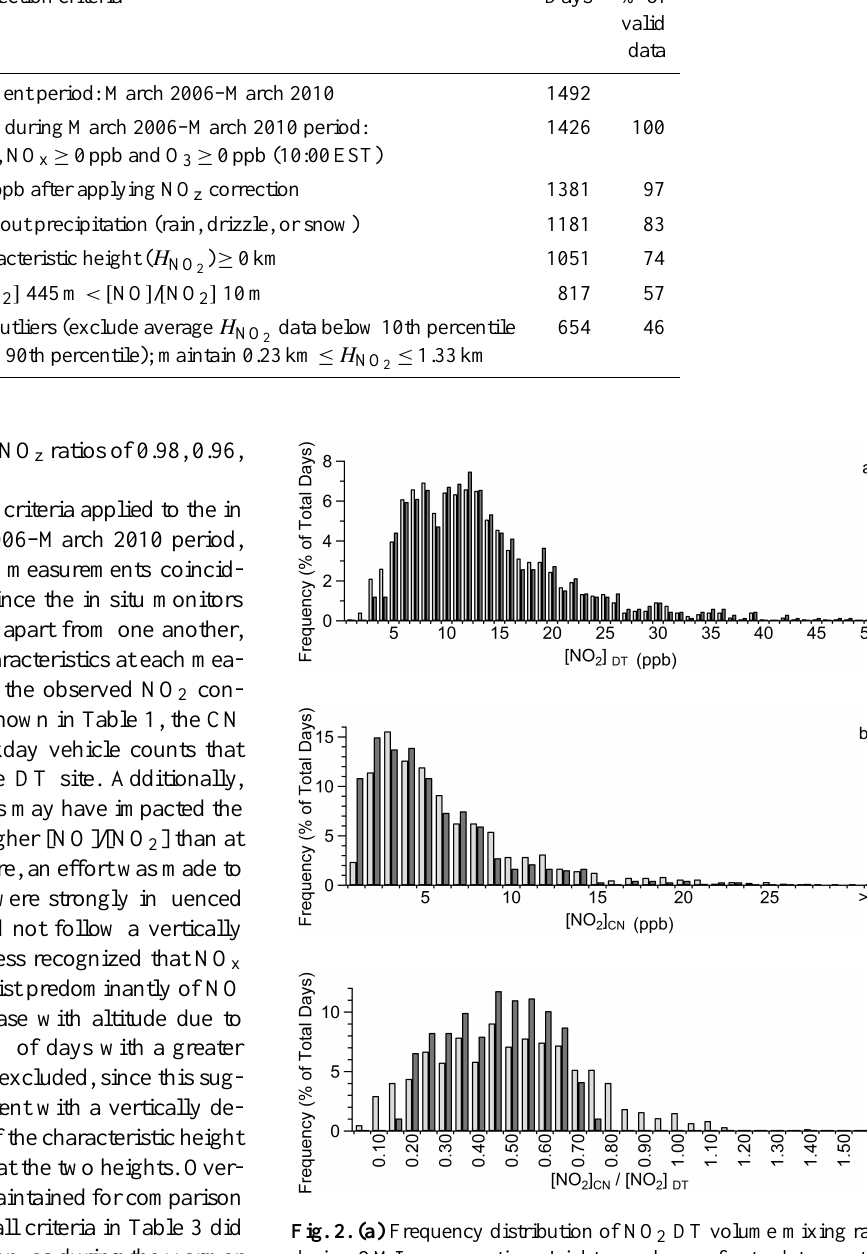
Table 3. In situ data selection criteria for the calculation of NO 2 VCD in situ . Day and % of valid data refer to in situ measurements averaged during the hours of 12:00–14:00EST to correspond with the OMI overpass time. In situ data selection criteria